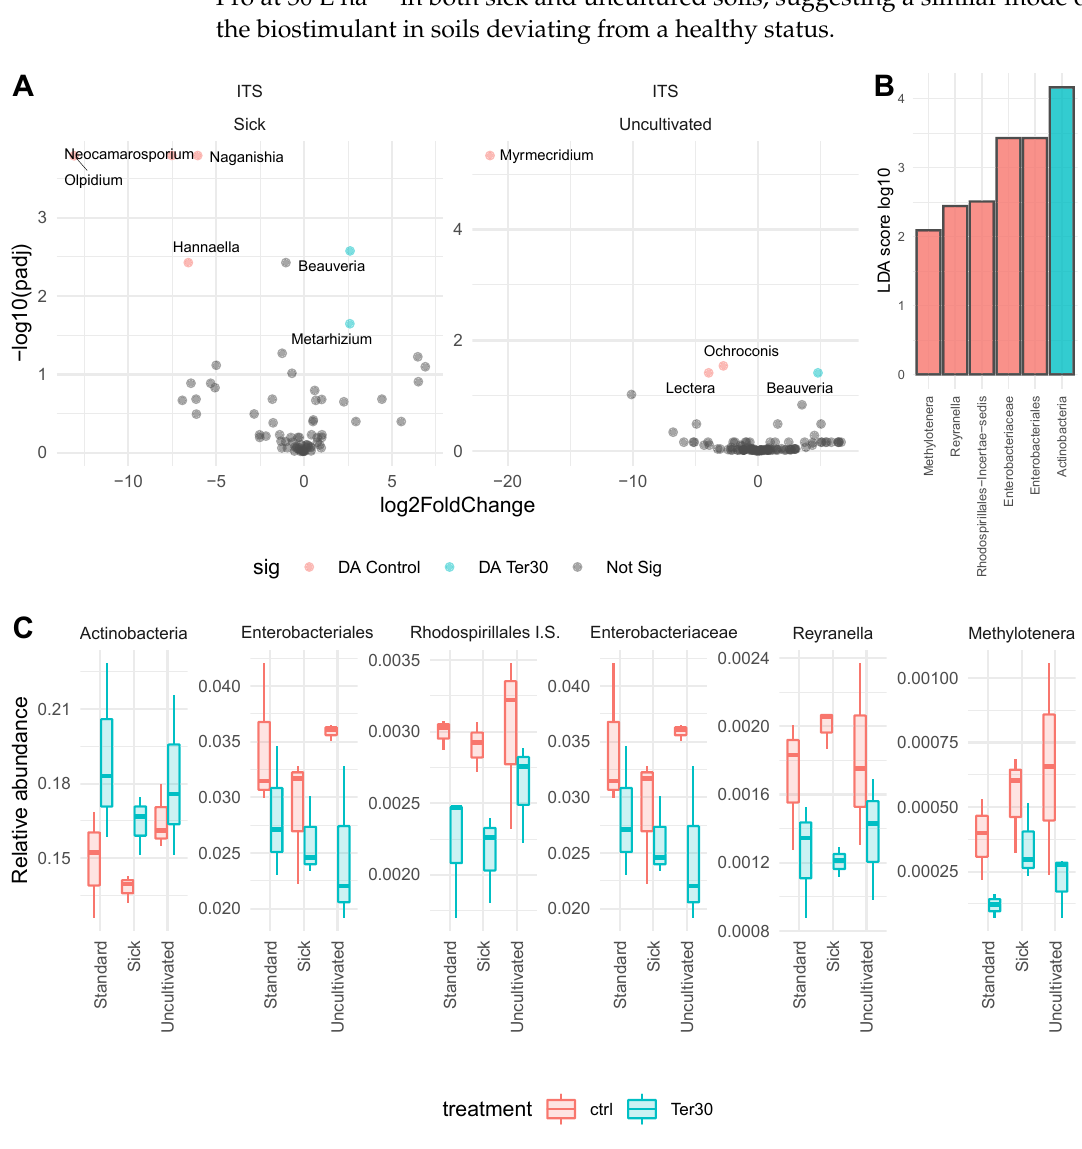
Figure 3. Volcano plot showing differential abundant taxa (absolute log fold change > 2 and adjusted p value < 0.05) at genus level in Terramin R (cid:13) Pro at 30 L ha − 1 compared to control condition after treatment T1 per soil type. Only markers and soil types presenting significant results are shown ( A ). Linear discriminant analysis (LDA) scores of bacteria and archaea microbiome at different taxonomic levels ( B ) and boxplot showing relative abundances of Terramin R (cid:13) Pro at 30 L ha − 1 and control conditions after the treatment T1 ( C